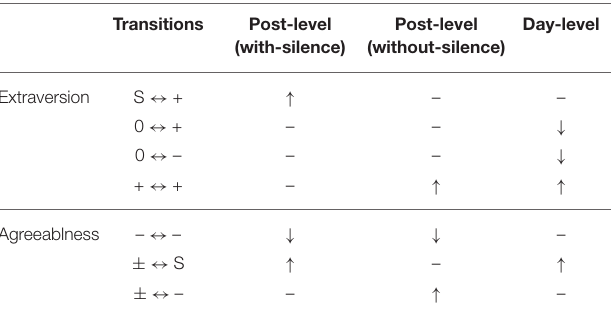
TABLE 4 | Summary of the significant correlations between transition states and the five personality traits ( p < 0.01). Transitions Post-level Post-level (with-silence) (without-silence)